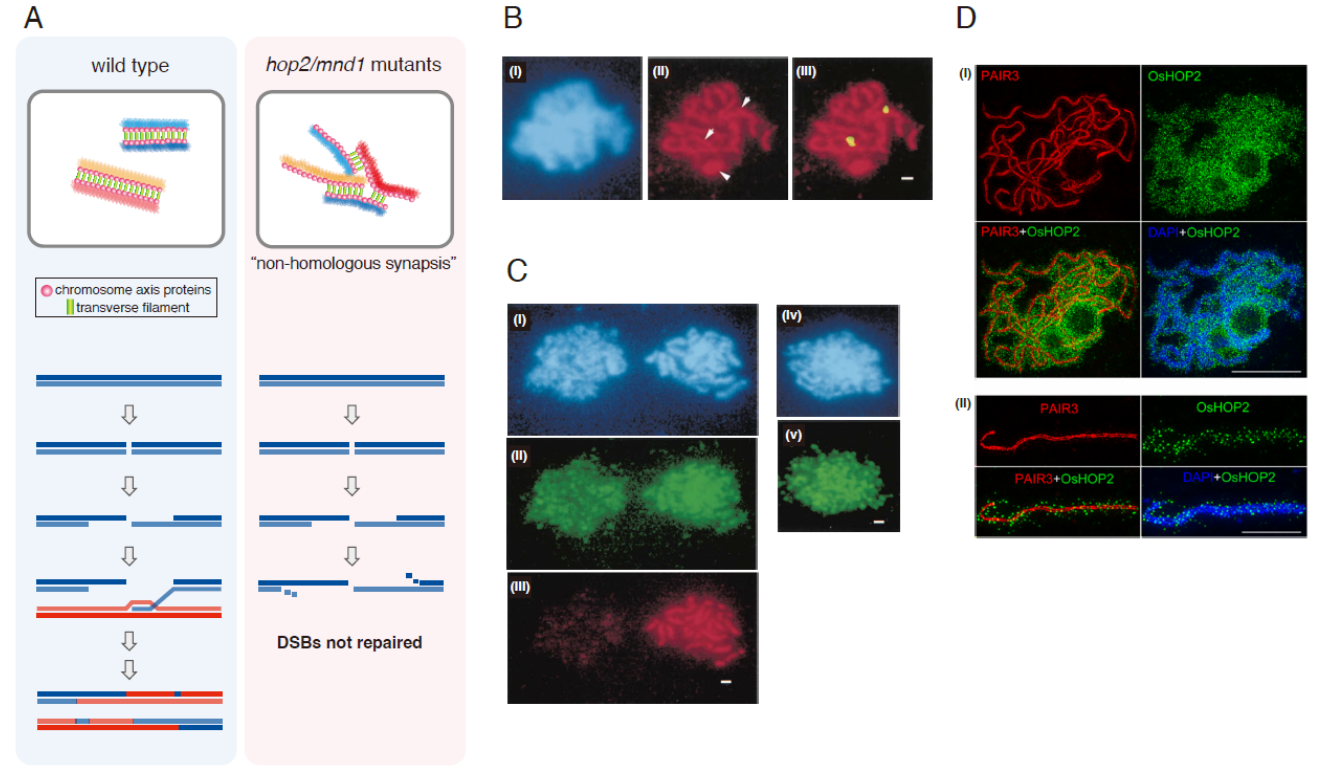
Figure 3. ( A ) Schematic drawing of the typical phenotypes of the hop2/mnd1 mutants in chromosome morphogenesis and homologous recombination. Synapsis occurs between nonhomologous chromosomes. DSBs successfully initiate and undergo resection, but strand invasion is hindered. ( B ) Meiotic chromosomes of a budding yeast hop2 strain are stained for ( I ) DNA, ( II ) Zip1, a marker for synapsed chromosomes, and ( III ) both Zip1 and chromosome ( III ). The arrows in ( II ) point to the sites of chromosome ( III ) signals in ( III ). Each unpaired chromosome III is engaged in synapsis. The arrowhead indicates a polycomplex, which is an aggregate of Zip1 often seen in recombination- defective mutants. Scale bar = 1 µ m. (From Leu et al. 1998 [31]; reprinted, with permission, from Elsevier). ( C ) Meiotic chromosomes at zygotene ( left ) and pachytene ( right ) are stained for ( I ) DNA, ( II ) Hop2, and ( III ) Zip1. Meiotic chromosomes of the spo11 strain (thus no meiotic DSBs) are stained for ( IV ) DNA and ( V ) Hop2. Scale bar = 1 µ m. (From Leu et al. 1998 [31]; reprinted, with permission, from Elsevier). ( D ) Localization of Oryza sativa Hop2 on structured illumination microscopy. ( I ) An Oryza sativa meiocyte at pachytene is stained for PAIR3 (meiotic chromosome axis protein), Hop2, and DAPI (DNA). Scale bar = 5 µ m. ( II ) A single pachytene chromosome showing most Hop2 foci are localized to the chromatin loops. (From Shi et al. 2018 [37]; reprinted, with permission, from John Wiley and